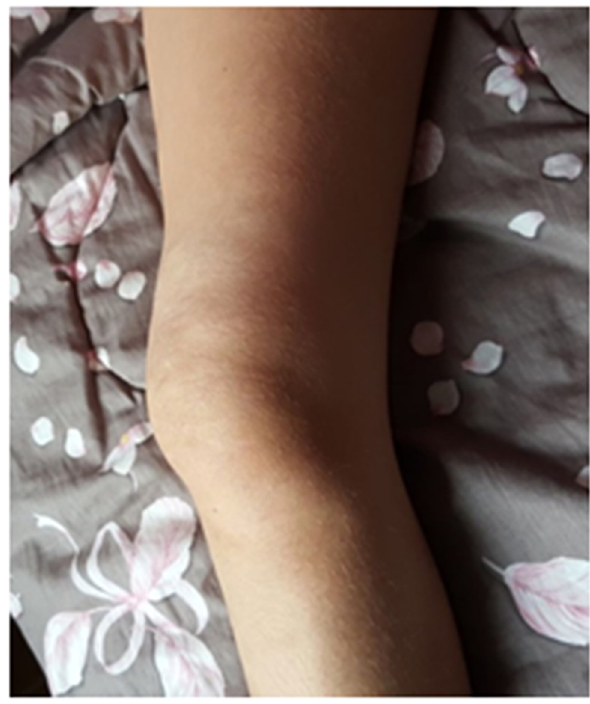
Figure 1: Injury of the vastus medialis muscle, which was visible on the clinical examination of the lower thigh. Parental consent was obtained for publication of this clinical